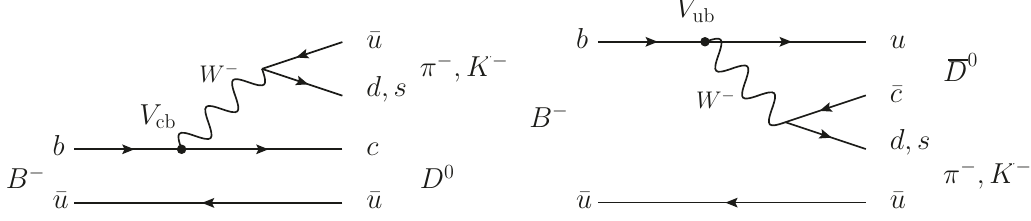
Figure 1 . Leading-order Feynman diagrams for B − → Dh − decays with a (left) favoured b → c and (right) suppressed b → u quark